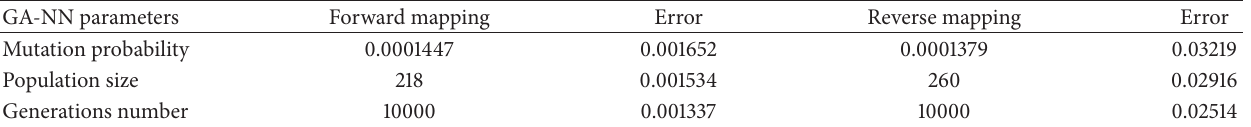
Table 3: GA-NN parametric study results of both forward and reverse mappings. GA-NN